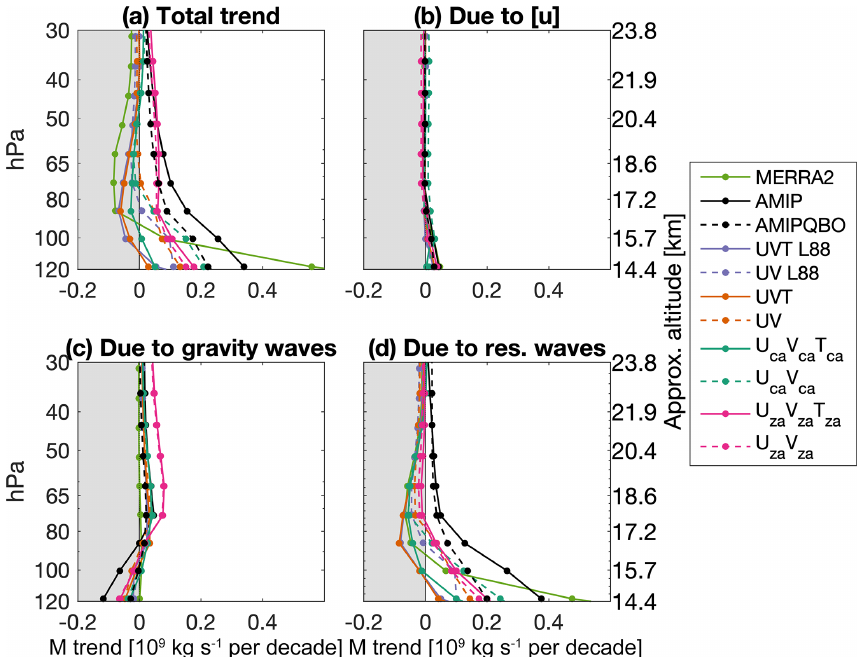
Figure 7. Tropical upwelling mass flux trends: (a) total trend, (b) trend due to zonal-mean zonal wind, (c) trend due to gravity wave momentum forcing, and (d) trend due to resolved wave momentum forcing. See text for details.